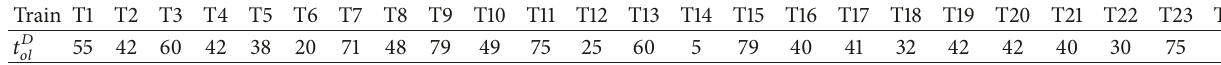
Table 1: Initial starting time of last trains in Beijing subway network (unit: min).